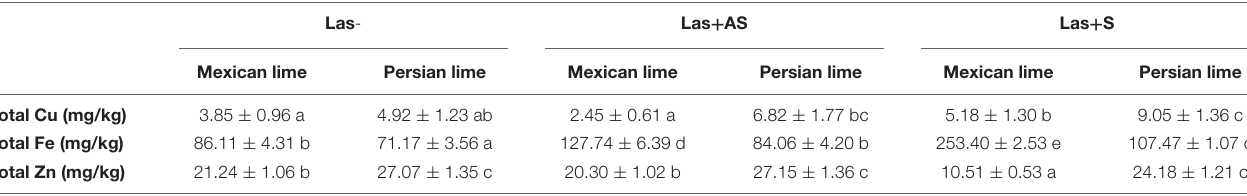
TABLE 6 | Cu, Fe, and Zn contents in control (Las − ) and infected leaves that were asymptomatic (Las + AS) and symptomatic (Las + S) from Mexican and Persian limes, respectively. Las - Las + AS Las + S